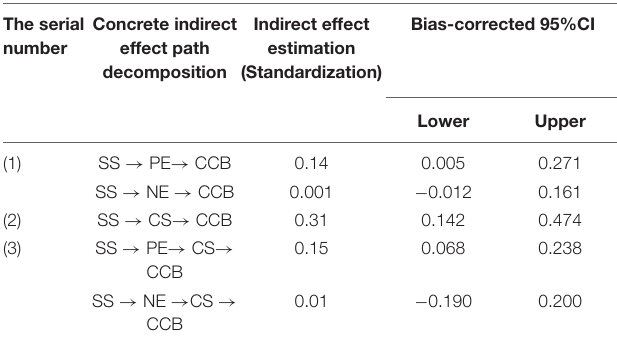
TABLE 6 | Mediating effect and 95% confidence interval estimated by Bootstrap